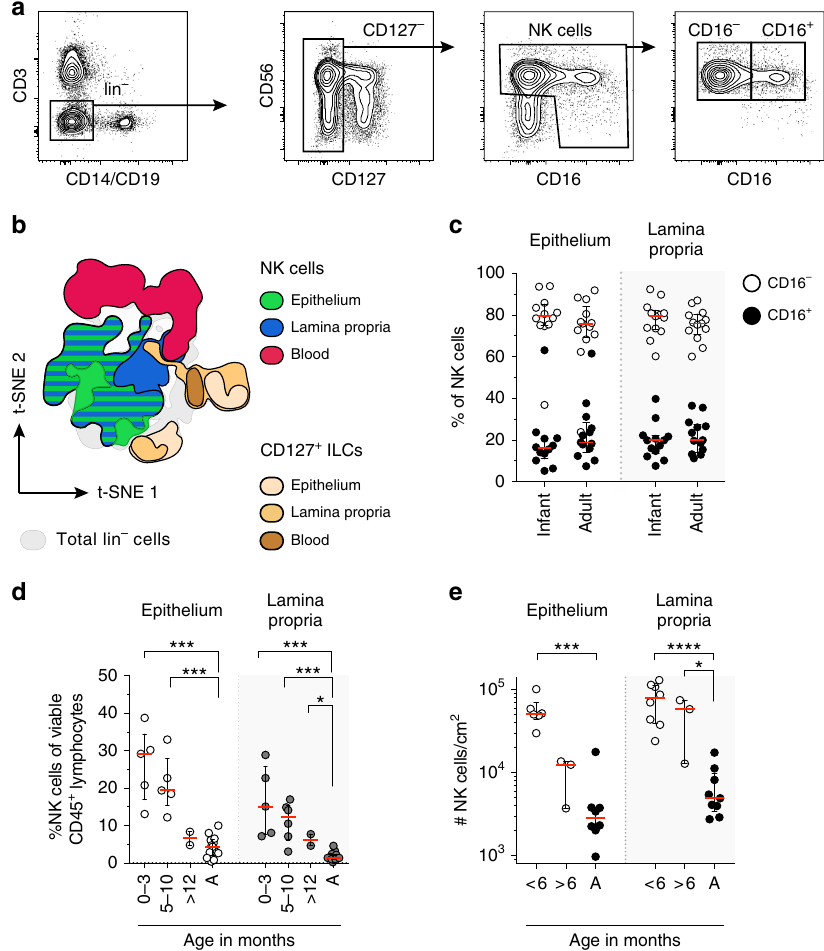
Fig. 2 NK cells are abundant in infant intestines. a Flow cytometric plots showing the applied gating strategy for intestinal NK cells (viable CD56 + CD127 − CD45 + lin − cells). FACS plots of a representative donor are shown. b viSNE plot of fl ow cytometric data showing gated NK cells and CD127 + ILCs from epithelium (EP), lamina propria (LP) and blood (B) within lin − populations (gray) ( N = 4). c Frequencies of infant and adult CD16 − (white circles) and CD16 + (black circles) NK cells from EP ( N = 12) and LP ( N = 13) tissues (infant samples), adult samples N = 13 (EP and LP). d NK cell frequencies of viable lymphocytes shown for different age groups in EP and LP tissues (infant samples N = 12 (EP) and N = 13 (LP), adult samples (A) N = 13 (EP and LP). e Absolute NK cell numbers per cm 2 for different age groups in EP and LP tissues (infant samples N = 9 (EP) and N = 11 (LP), adult samples (A) N = 8 (EP), and N = 9 (LP)). Median frequencies indicated by red lines. Error bars de fi ne interquartile ranges between 75th and 25th percentiles. Statistical comparisons are Mann-Whitney U comparisons. Asterisks represent the following p -values: * p < 0.05; *** p < 0.001; and **** p <